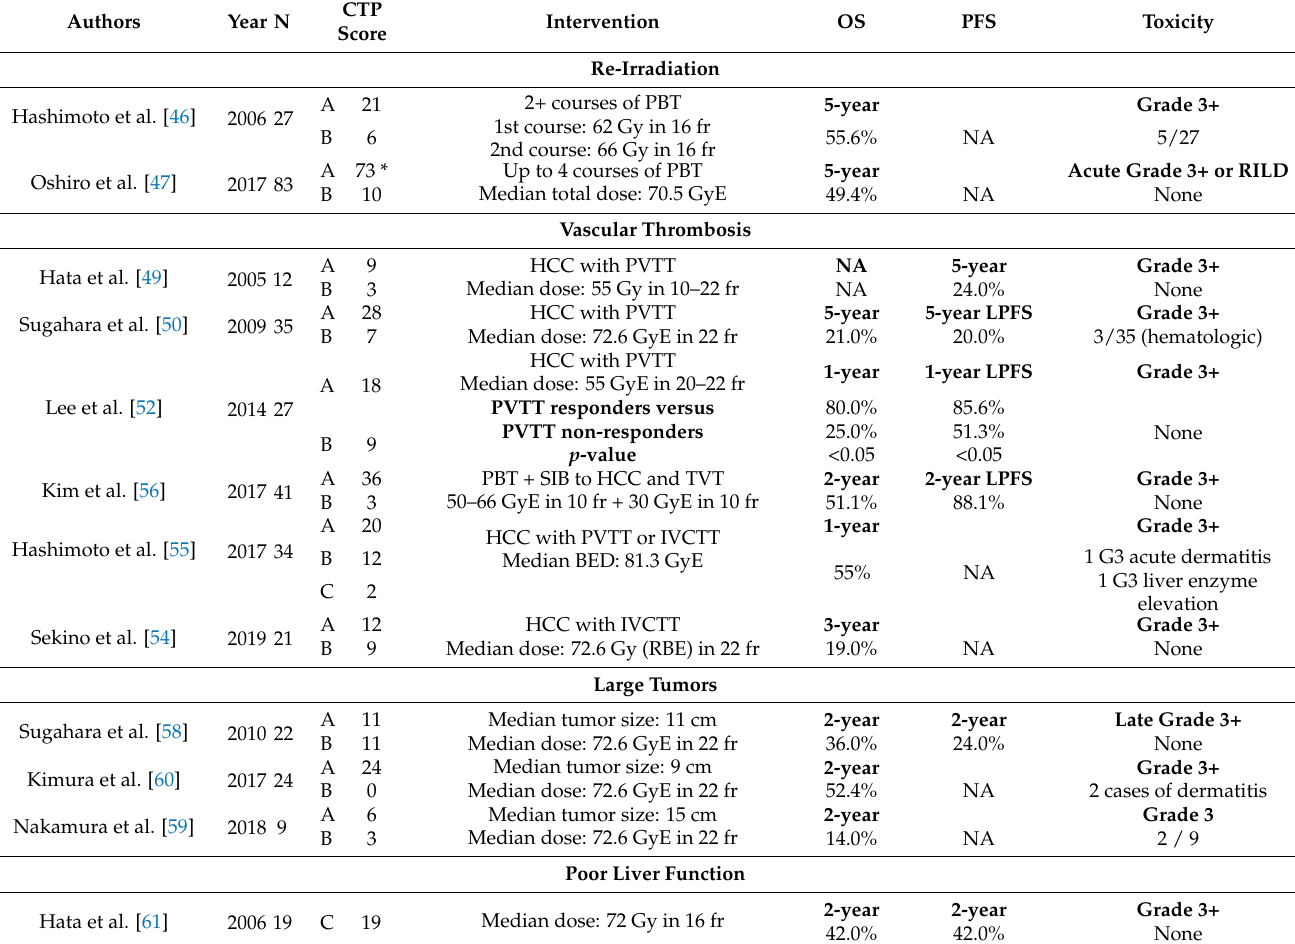
Table 1. Key studies on the use of proton beam therapy for HCC in the settings of re-irradiation, vascular thrombosis, large tumor size, or poor liver